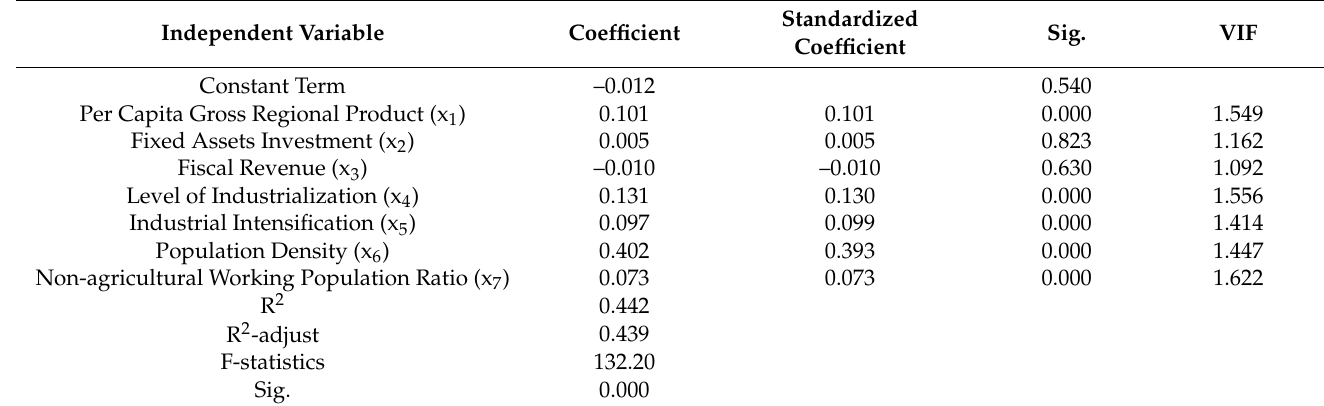
Table 3. Results of the OLS